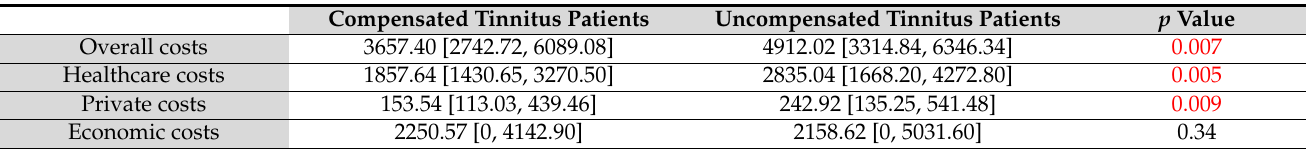
Table 7. Results (median [interquartile range]) of Mann–Whitney U tests of yearly socioeconomic costs for compensated and uncompensated tinnitus